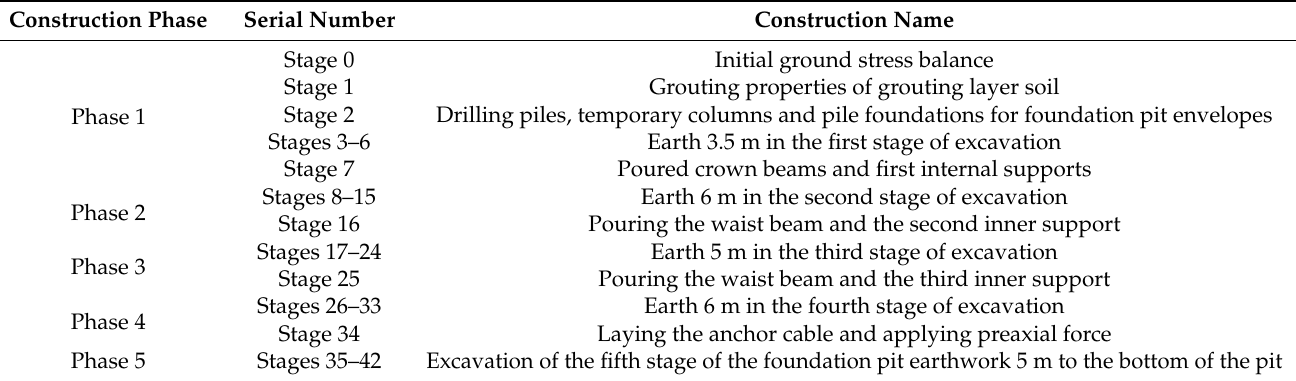
Table 8. Finite element model numerical simulation